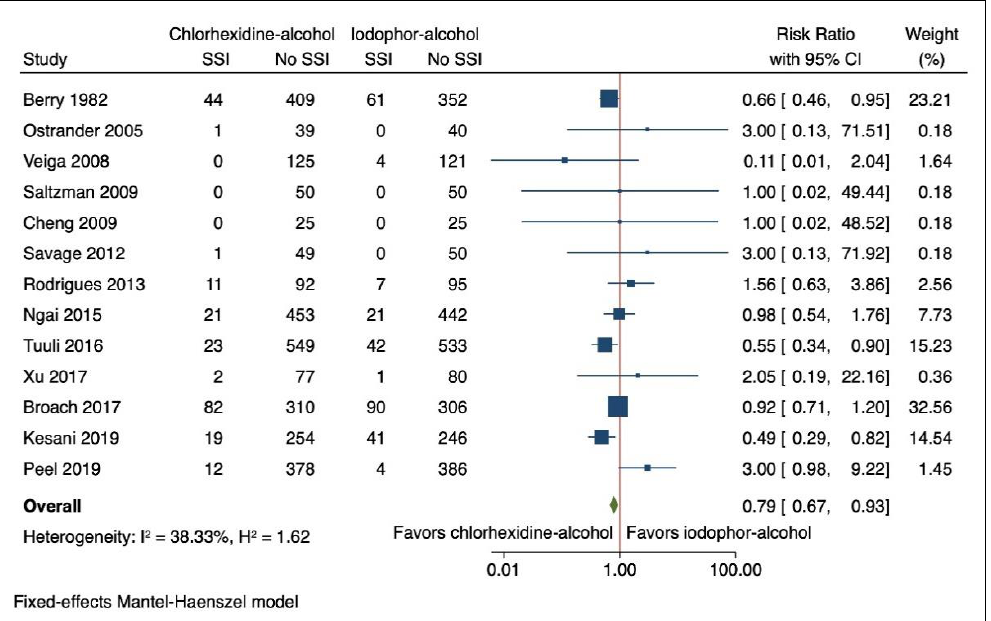
Figure 2 . Forest Plot Comparing Risk of Surgical Site Infection (SSI) with Chlorhexidine-Alcohol to Iodophor-Alcohol Surgical Site Skin Preparation. Navy square represents the effect estimates from the individual studies, the size of the square is proportional to the weight of the study. The horizontal line represents the 95% confidence interval of the study estimate. The green diamond represents the pooled effect size.